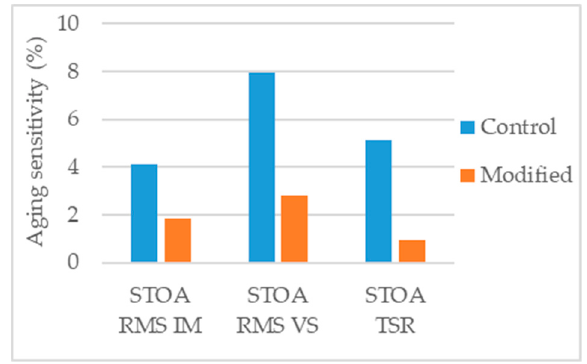
Figure 18. Aging sensitivity of the parameters considered in the study [62].